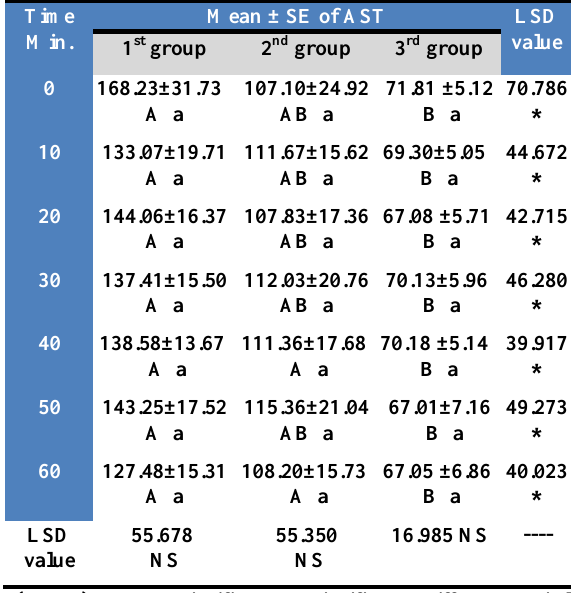
Table, 8: Show effect the treatment on the level of